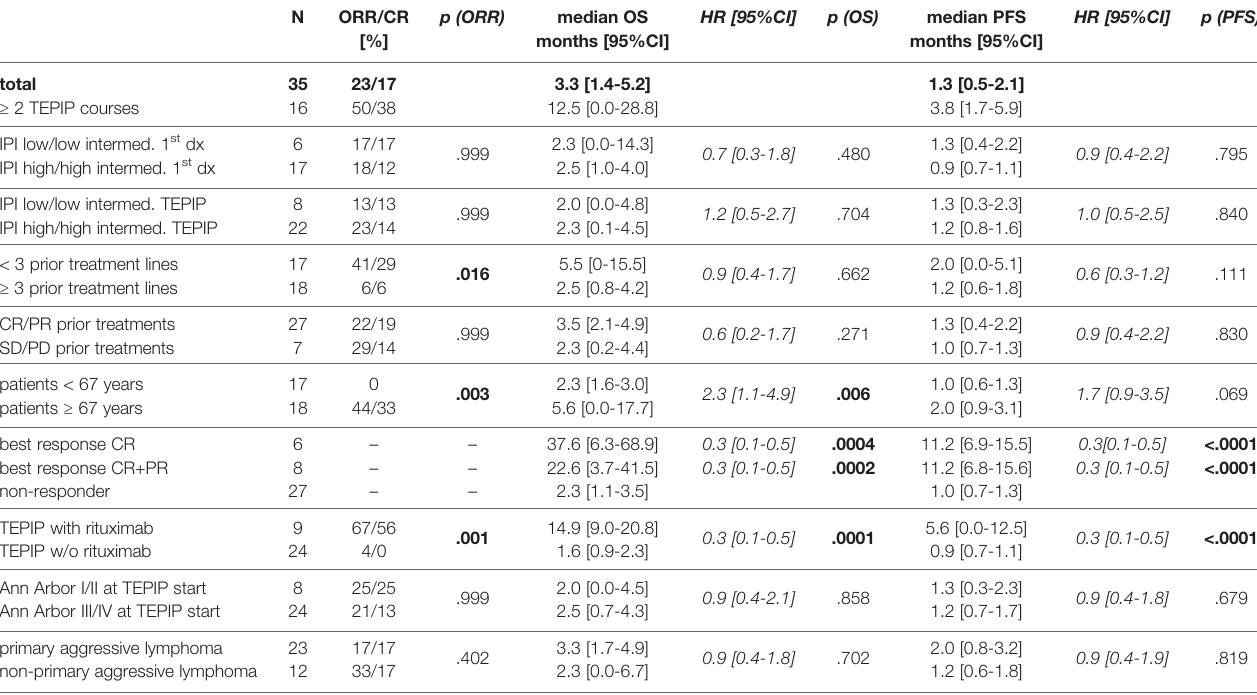
TABLE 2 | Response in patients receiving TEPIP.